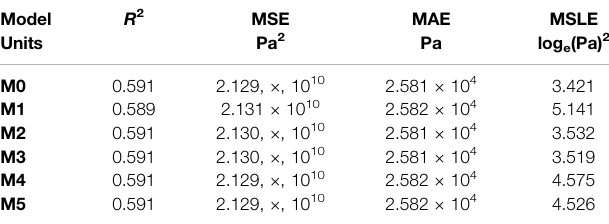
TABLE 2 | Comparison of metrics R 2 (coef fi cient of determination), MSE (mean squared error) in Pa 2 , MAE (mean absolute error) in Pa, and MSLE (mean squared logarithmic error) in log_e